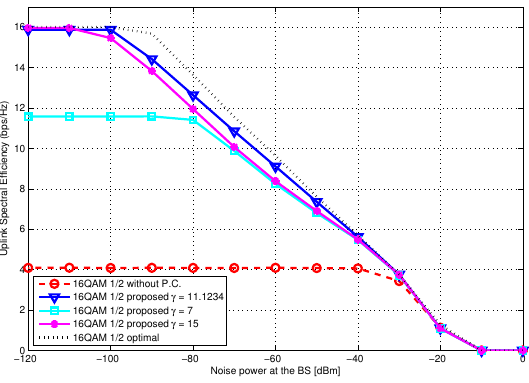
Figure 11. Spectral efficiency for 16QAM-1/2 versus noise power with different values of γ